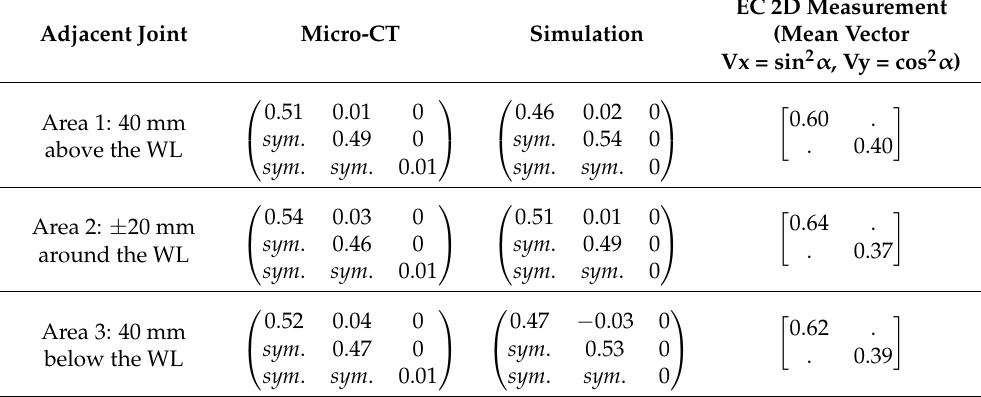
Table 7. Mean orientation tensor measured for the Butt specimen of scanned area marked as 1, 2, and 3 using Micro-CT, simulation, and eddy current. The failure location is highlighted in red. Scan locations and coordinate system are shown in Figures 15 and 16. The red dashed area corresponds to Area